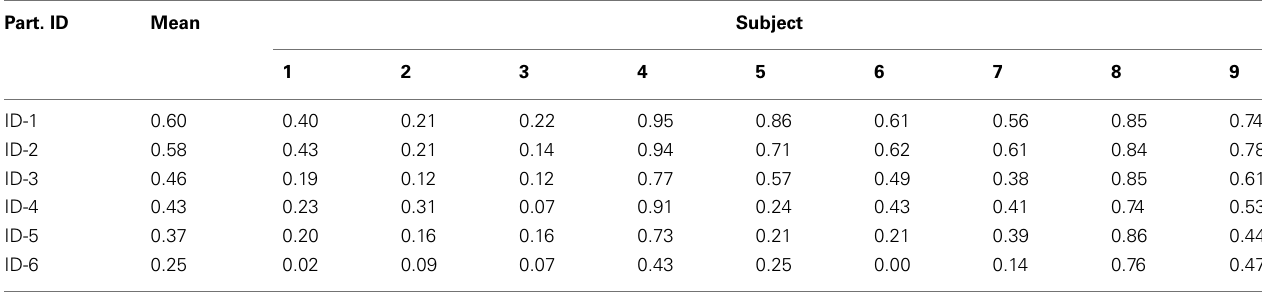
Table 4 | (Data Set 2b). Detailed results from the BCI competition IV. Part.